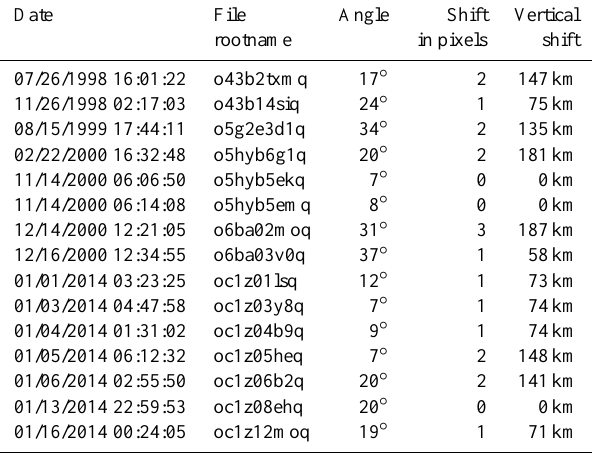
Table 3. List of the STIS G140L spectral observation used to deter- mine the shift between the H 2 brightness peak locations in the 123– 130nm range and the 155–162nm range. The angles between the slit and the normal to the local limb are noted in the third column. The fourth column indicates the shift between the unabsorbed and the absorbed brightness peaks as measured in pixels in the spectra. Finally, the fifth column displays a conversion of these shifts into kilometers, accounting for the cosine of the angle. Dates are given in the format of